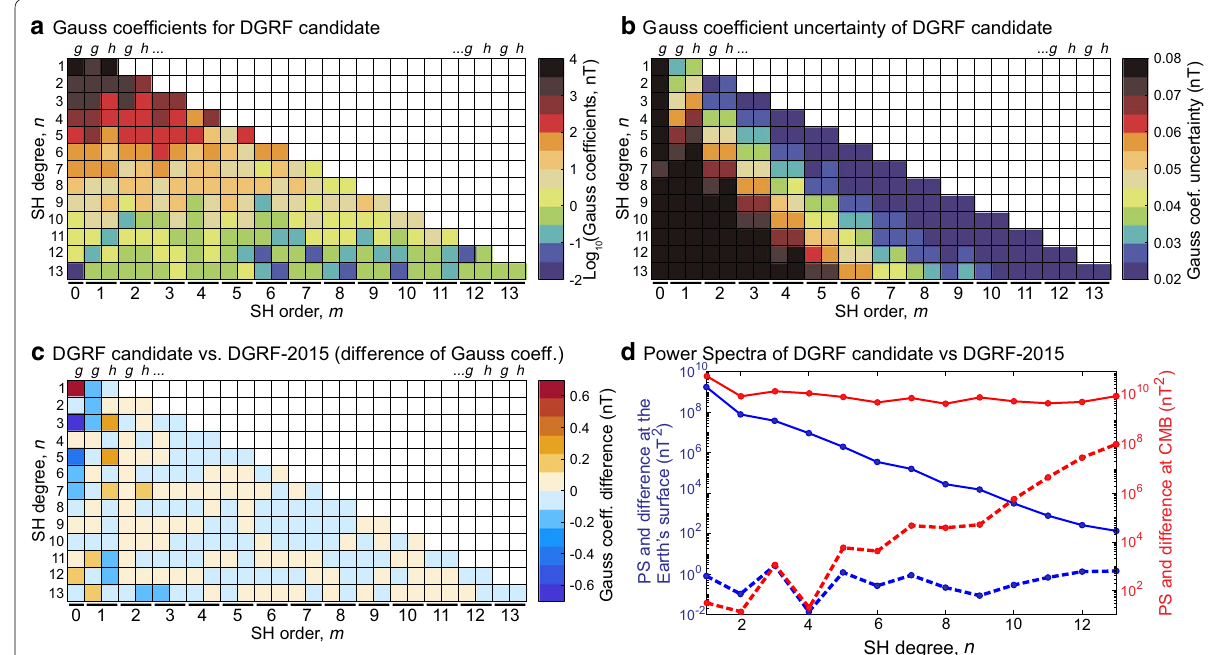
Fig. 8 DGRF candidate model. a Gauss coefficients and b the uncertainties given by the 1‑ σ of their normal distributions. c Gauss coefficient differences between our DGRF candidate and the published DGRF‑2015 model. d Power spectrum at the Earth’s surface (blue line referred to the left y ‑axis) and at the CMB (red line referred to the right y ‑axis). Differences of the power spectrum between our candidate and the DGRF‑2015 model is also given by dashed lines (blue at Earth’s surface and red at